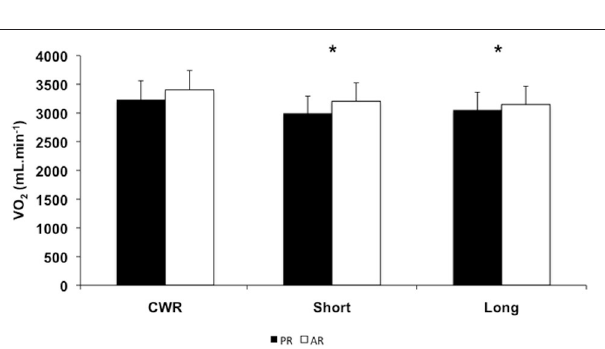
FIGURE 3 | Mean ± SD values of the end-exercise VO 2 obtained during the exercise performed in different conditions for passive (PR) ( N = 9) and active (AR) ( N = 9) groups. CWR—constant-work-rate exercise; * p < 0.05 in relation to CWR.